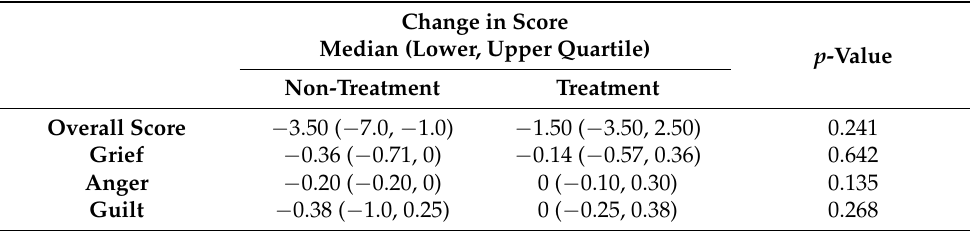
Table 4. The median change in overall and factor bereavement scores (grief, anger, and guilt) between pre- and post-questionnaires in both the non-treatment (n = 6) and treatment groups (n = 8) 1 .